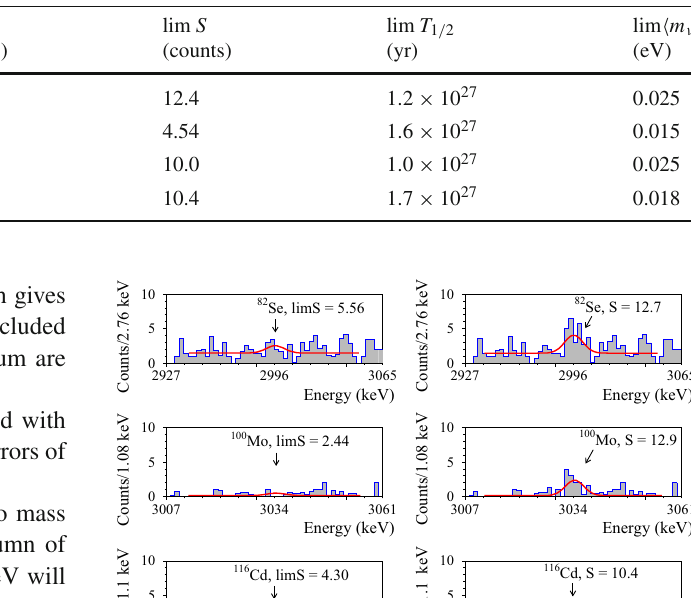
Table2 SensitivityofCUPID-1experimentswithZn 82 Se,Li 100 MoO 4 , at 90% C.L. The neutrino mass limits are calculated by using the matrix 2 116 CdWO 130 TeO elements from Ref. [46], the phase space factors from Ref. [47] and the 4 and 2 detectors assuming the background in the ROI value of the axial vector coupling constant g A = 1 . 27 simulated in Ref. [44] (denoted as I BG , counts/yr/keV/kg). The limits on the number of events, the half-lives and the neutrino mass are given